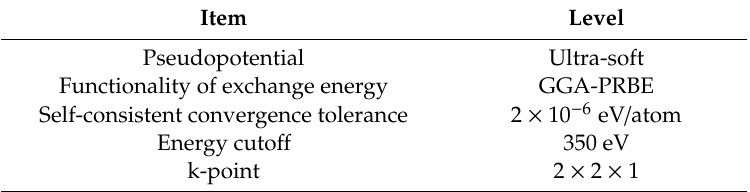
Table1. Simulationparameters. GGA-PRBE:Perdew–Burke–Ernzerhofgeneralizedgradientapproximation.